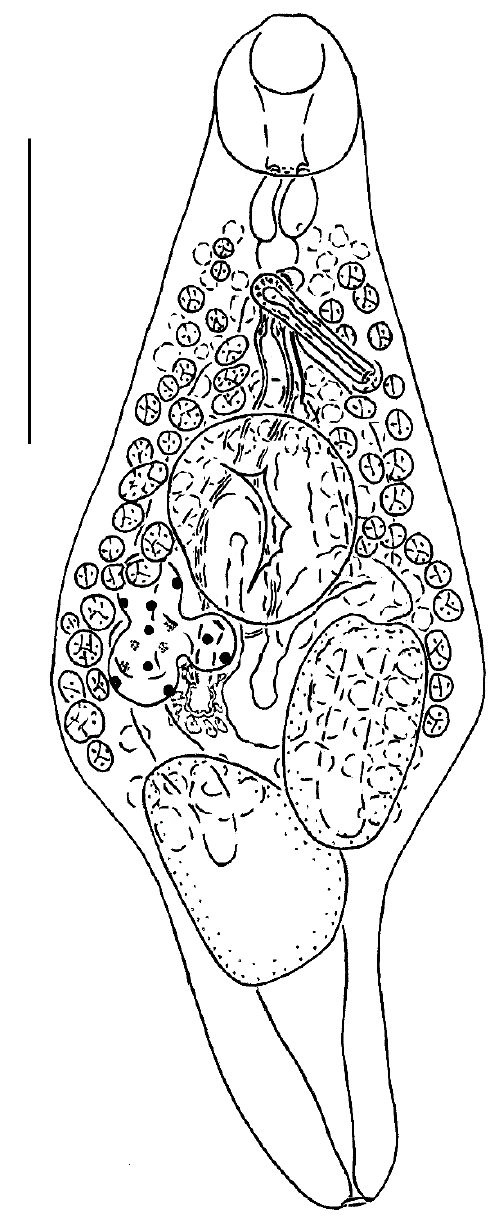
Figure 2. Stenakron vetustum Stafford, 1904 from intestine of Falcate snailfish Careproctus cypselurus (Jordan and Gilbert, 1898) (Liparidae), the Sea of Okhotsk. Scale bar = 400 µ m. Site of infection: